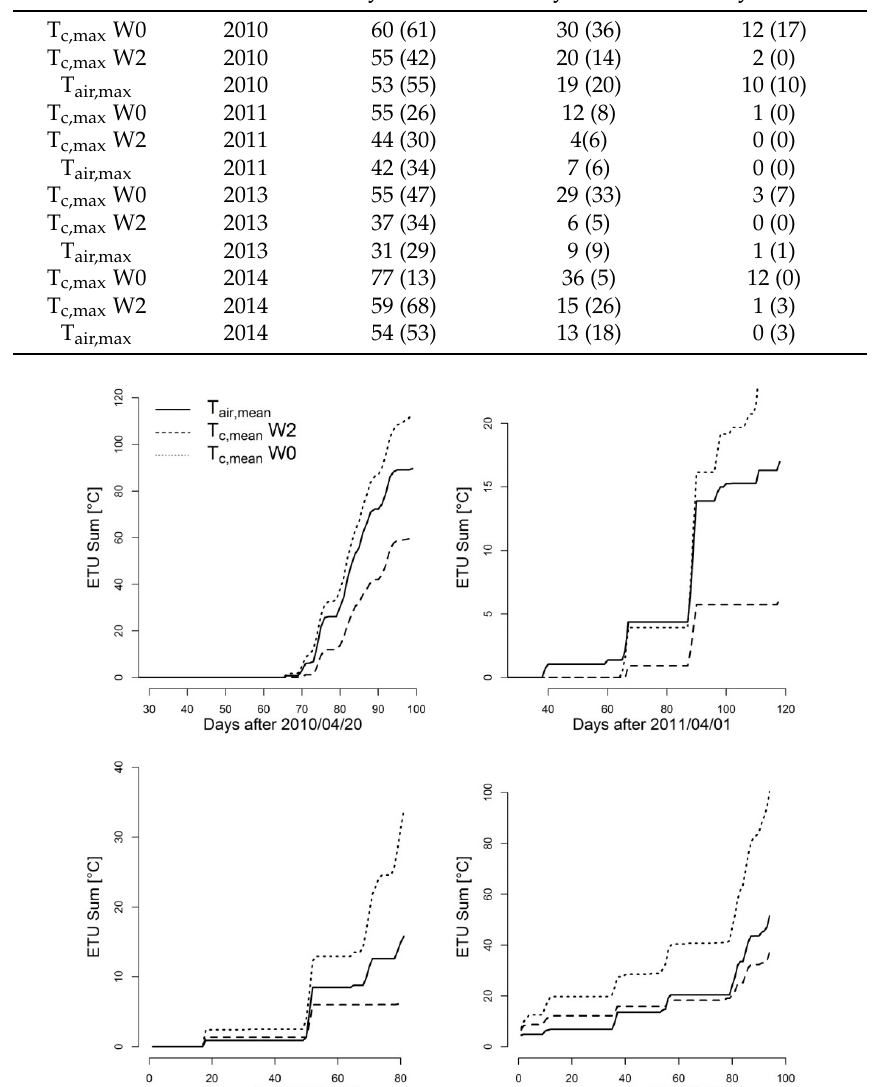
Figure 8. Extreme thermal unit sums above the optimal temperature of 20 °C (ETU, [52]) for the modeled mean daily crop temperature of the drought treatment plot (T c,mean W0, dotted line), the fully irrigated plot (T c,mean W2, dashed line) and for the measured mean daily air temperature (T air,mean , solid line) in 2010 ( top left ), 2011 ( top right ), 2013 ( bottom left ), 2014 ( bottom right ) (Hohenschulen research site).